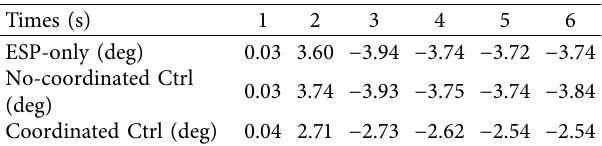
Table 4: Table of roll angle changing with time in Fishhook test condition. Times (s)